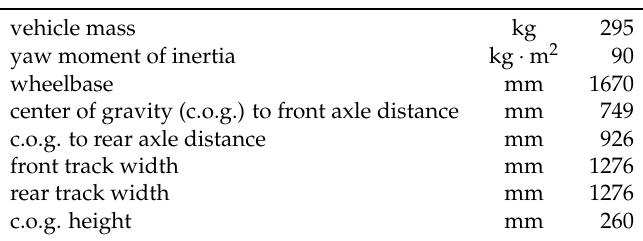
Table 1. Main vehicle